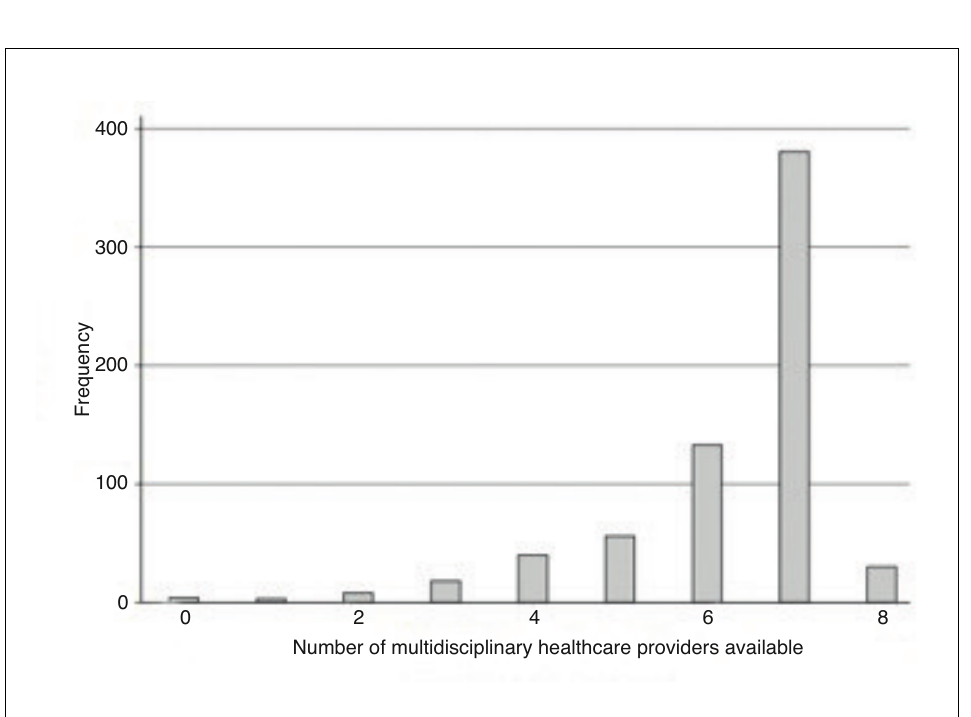
Figure 2. Histogram showing total number of MHCPs available to GP